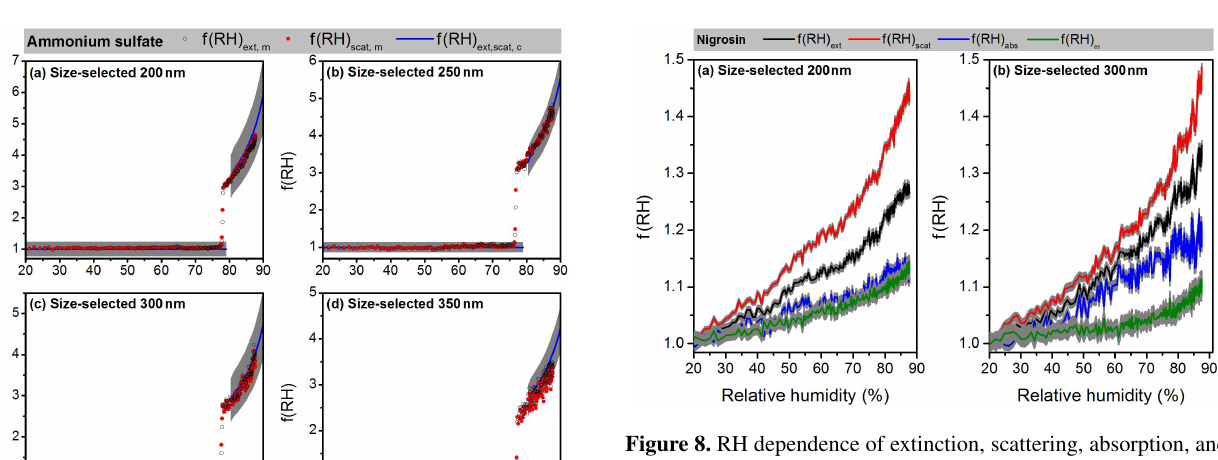
Figure 8. RH dependence of extinction, scattering, absorption, and ω enhancement for size-selected (a) 200nm and (b) 300nm dry di- ameter nigrosin particles. The black, red, blue, and green lines rep- resent the measured f (RH) ext , f (RH) scat , f (RH) abs , and f (RH) ω , respectively. The grey areas represent the measurement uncertain-